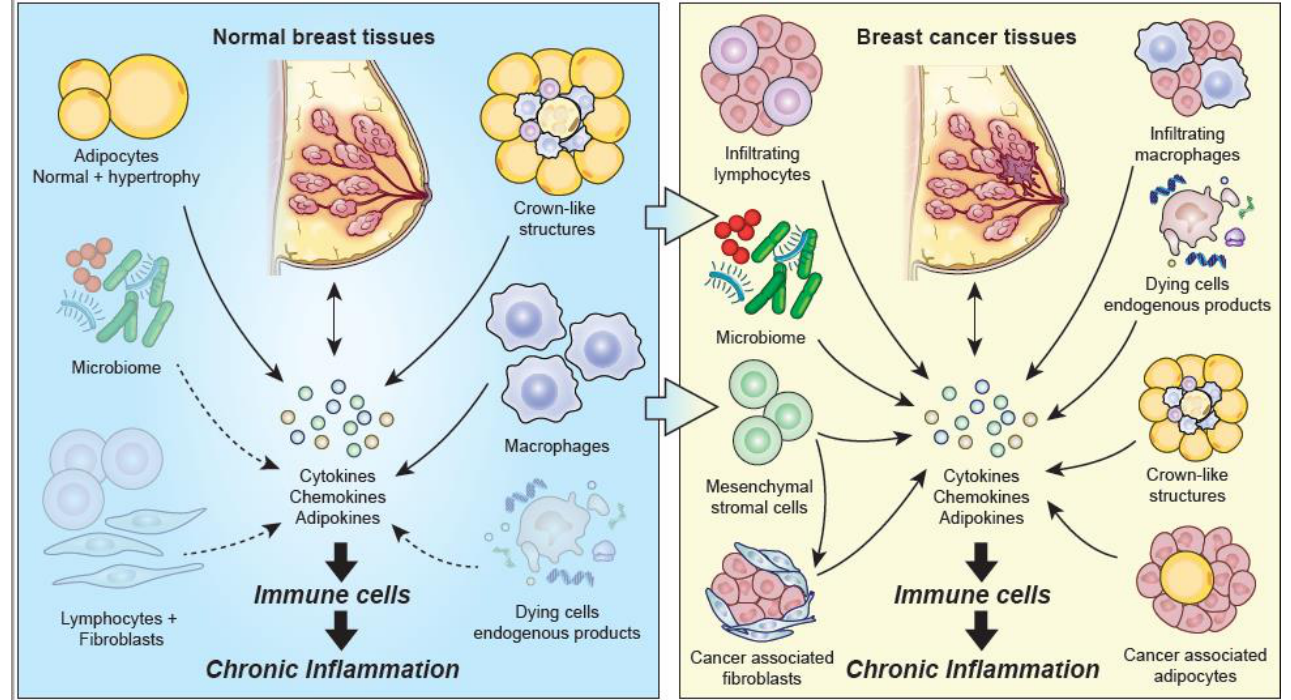
Figure 1. Chronic inflammatory processes in normal breast tissue and breast cancer tissue. Normal Breast tissue (left panel): Chronic inflammation may be initiated in the normal breast from several cell types. Hypertrophied adipocytes and crown-like structures are the most prominent focus and secrete multiple proinflammatory cytokines, including chemokines, and adipokines which promote chronic inflammation. The microbiome, dying or injured cells, and lymphocytes and fibroblasts, are shaded to indicate they are present in normal breast tissue, but their role in promoting chronic inflammation may occur later in breast carcinogenesis. Breast cancer tissue (right panel): Multiple cellular processes are present in breast cancer promoting chronic inflammation. Infiltrating lymphocytes and macrophages, cancer-associated adipocytes and crown-like structures, mesenchymal stem cells and cancer-associated fibroblasts that secrete multiple proinflammatory cytokines, including chemokines and adipokines, while the microbiome and dying or injured cells interact with immune cells through MAMPS and DAMPS to promote chronic inflammation (DN Danforth, original figure).